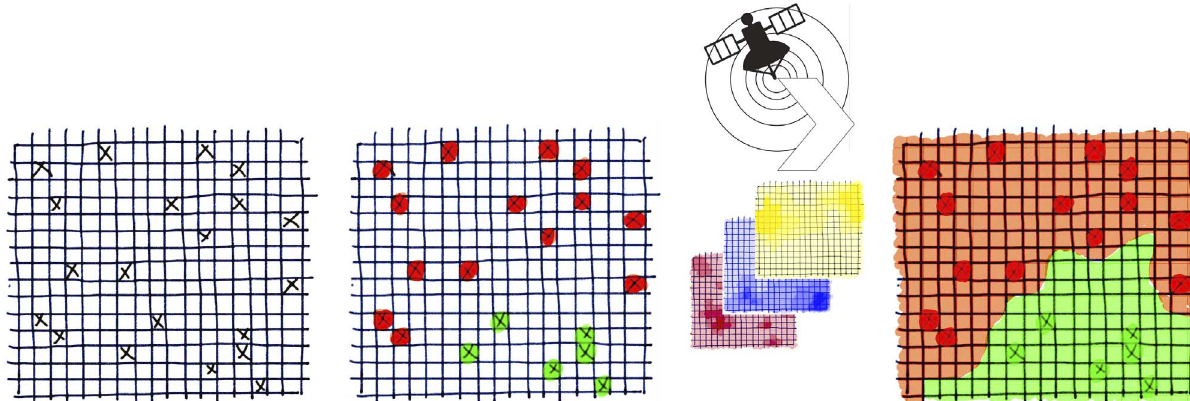
Figure 1. General approach to designing species distribution maps.